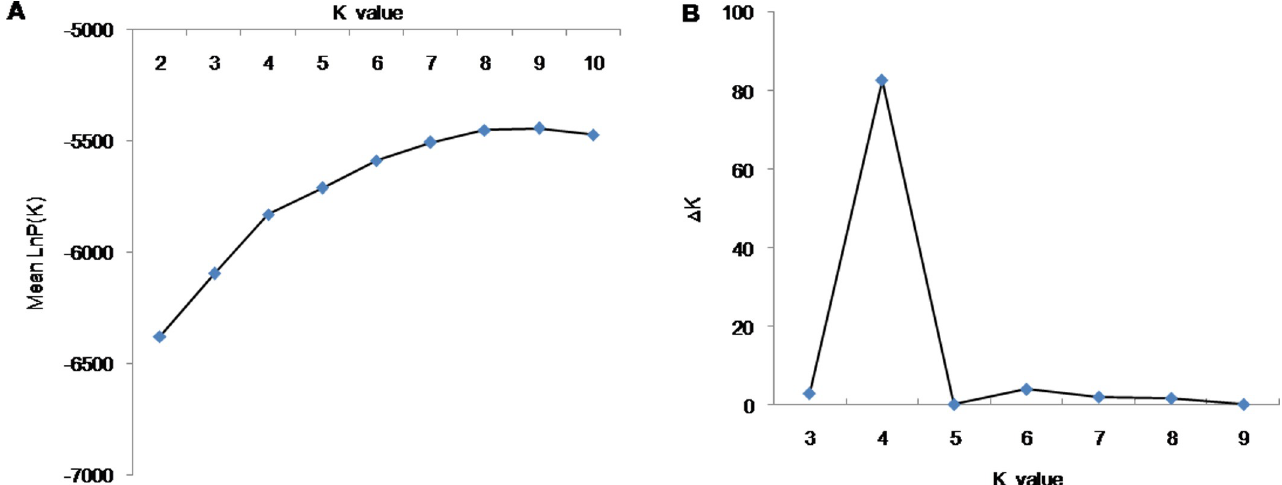
Fig 5. The estimated mean log-likelihood of K values (A) and Δ K values